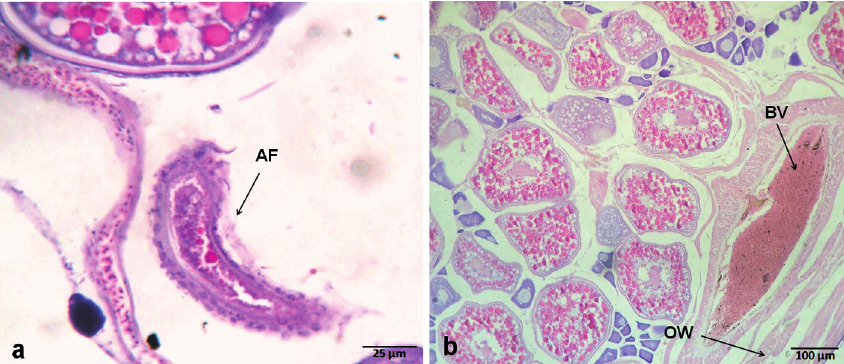
Fig. 3. Photomicrographs of germ cells and somatic structures of ovaries of black triggerfish caught in the São Pedro e São Paulo Archipelago, between January 2006 and May 2008. ( a ) AF - atretic follicle; ( b ) BV - blood vessel; and OW - ovary wall.